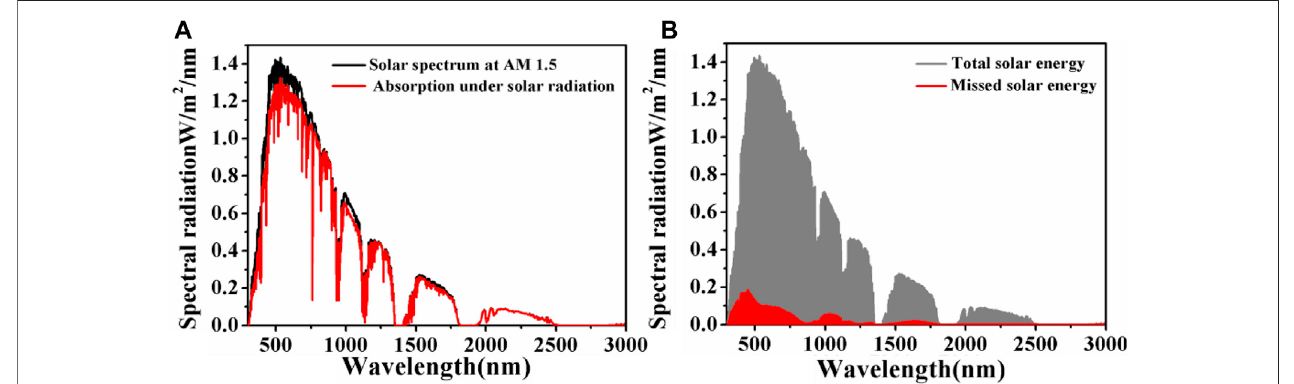
FIGURE 6 | (A) Solar energy absorption spectrum (B) Comparison of energy absorption and loss.